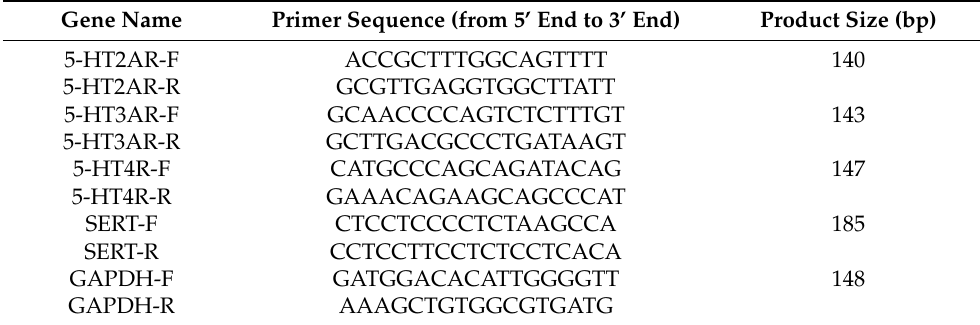
Table 1. The primers used in this